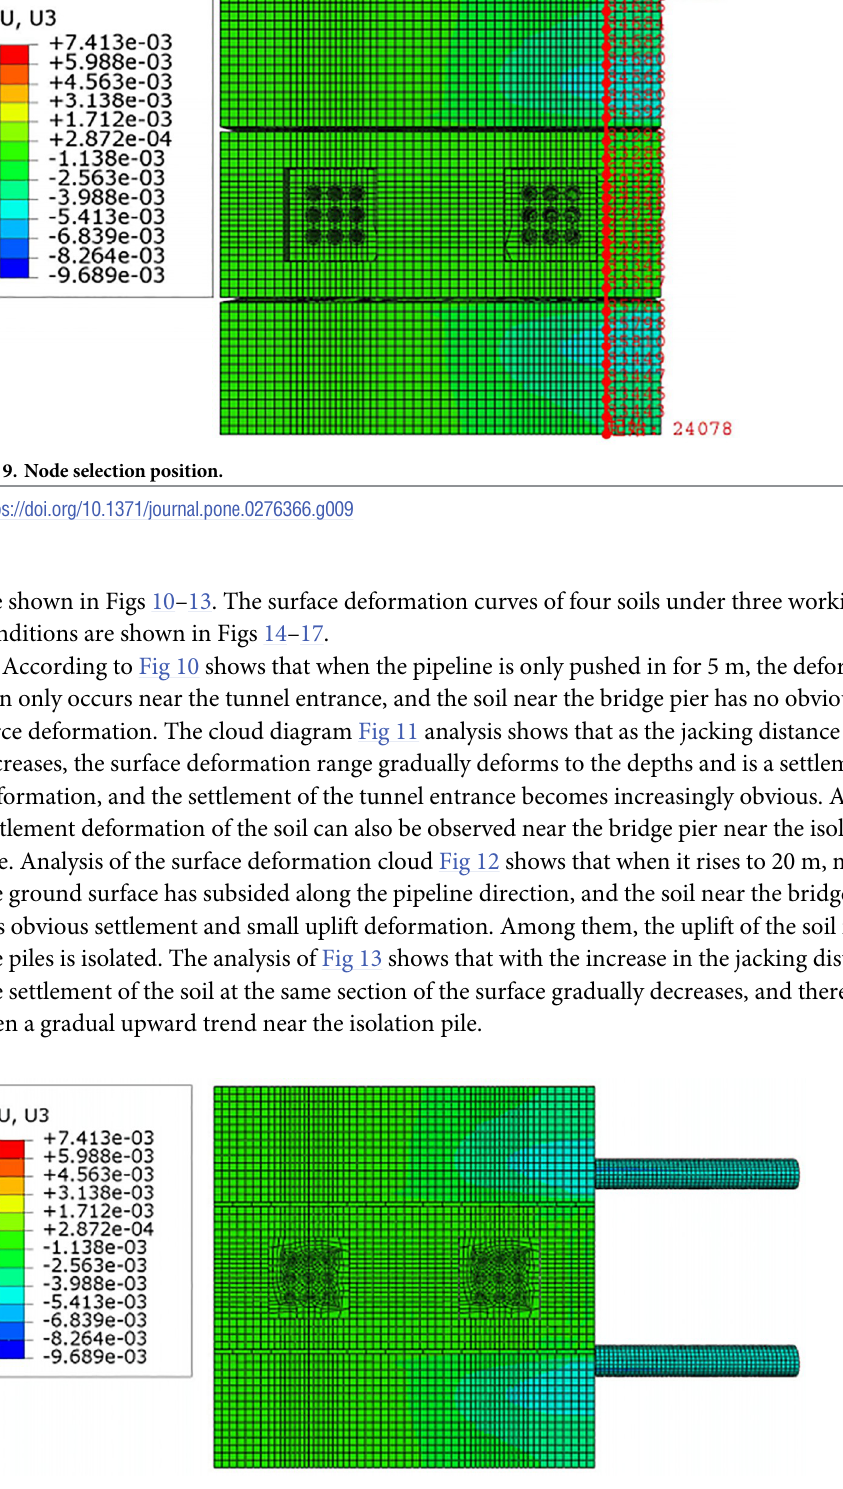
Fig 10. Model surface deformation clouds of loess-like soils at pipe jacking up to